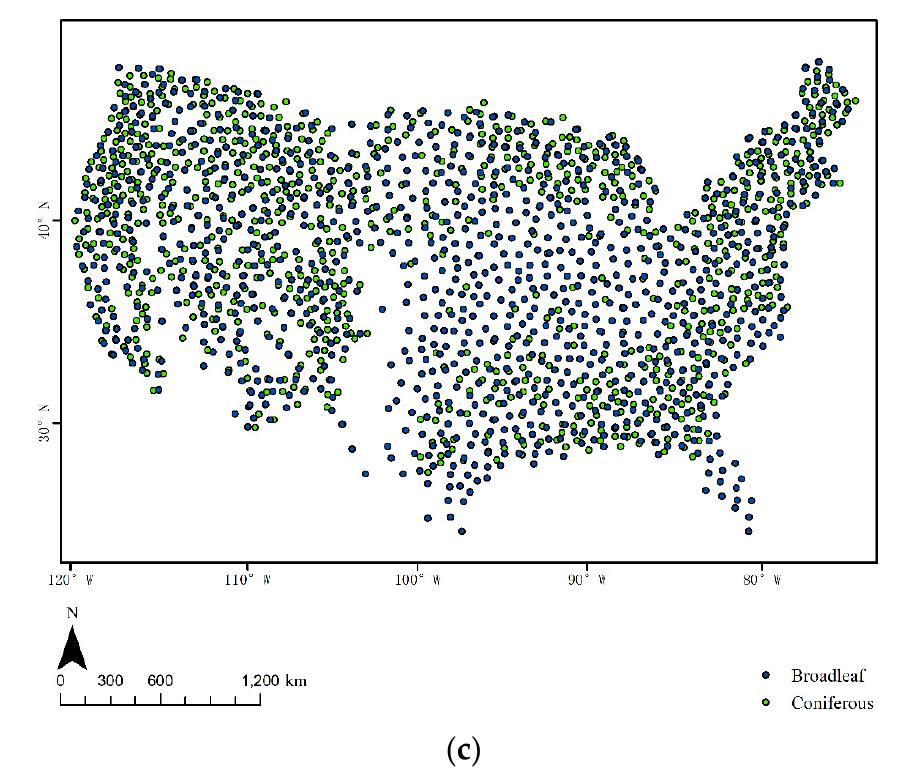
Figure 8. Verification points: ( a ) distribution of verification points of different sources; ( b ) distribution of verification points of different types; ( c ) randomly distributed visually interpreted sample points.